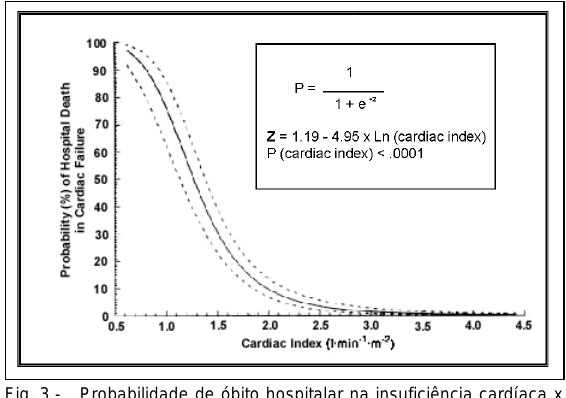
Fig. 3 - Probabilidade de óbito hospitalar na insuficiência cardíaca x índice cardíaco. (Fonte: Kirklin J W & Barrat-Boyes B G. Cardiac surgery. 2.ed. New York: Churchill Livingstone, 1993.